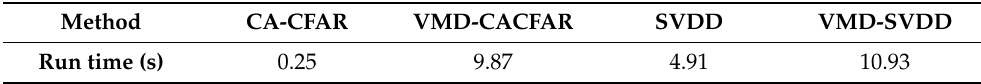
Table 2. Real-time analysis of four